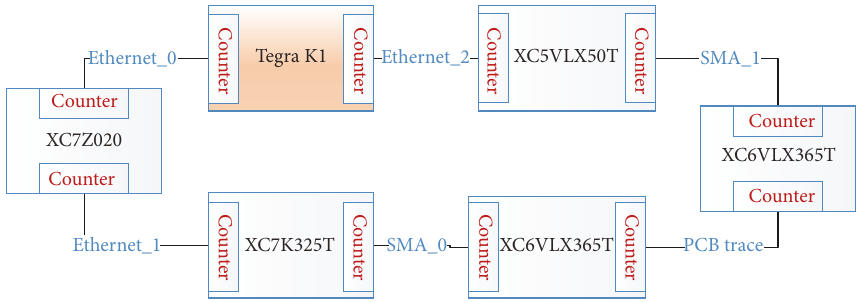
Figure 13: Counters’ location and interconnection’s